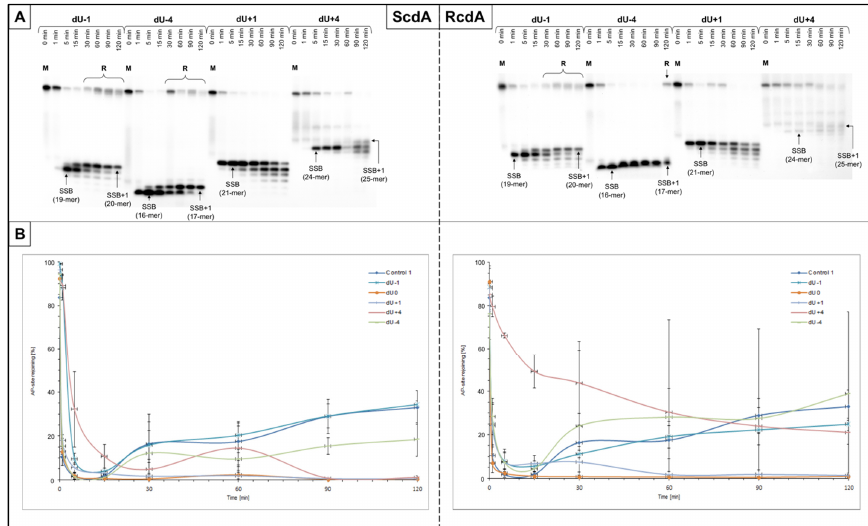
Figure 3. ( A ) The representative autoradiograms presenting the nuclear BER in XPC cell line (the strand incision, elongation, and repair) of dsDNA containing double-stranded clustered DNA lesions (dsCDL) with AP site and ScdA or RcdA on opposite strands distanced by 1–4 base pairs in 3 ′ -end direction (negative numbers) or 5 ′ -end direction (positive numbers); M—length marker (40-mer dsDNA with a single AP site); R—rejoined strand (40-mer dsDNA); SSB—single-strand break (AP site cleavage resulting from the endonucleolytic activity of nuclear extract); SSB+1/SSB+2—cleaved strand with 1 or 2 nucleotide unit incorporated (resulting from polymerase activity of nuclear extract). Each experiment was performed three times for consistency. ( B ) Graphical representation of the AP site rejoining trends (strand reconstitution). Graphs in higher resolution and autoradiograms of all experimental repeats are available in the Supplementary Materials. For the XPC cells, strands containing ScdA were incised with efficiency above 70% after following times: 1 min for ScdA/dU+1; 5 min for ScdA/dU − 1 and ScdA/dU − 4; and 15 min for ScdA/dU+4 (Figure S5B, Table S3). Interestingly, overall incision yields for ScdA were higher than for Control 1 (57.83 ± 7.31% after 5 min, Table S2). For oligos with RcdA, the incision efficiencies were lower than Control 1 (Figure S6, Tables S2 and S4). The fol- lowing AP site incision rates were noted: 50.23 ± 18.55% after 5 min for RcdA/dU+1; 52.18 ± 19.25% after 5 min for RcdA/dU − 4; 48.64 ± 5.15% after 5 min for RcdA/dU − 1; and 23.16 ± 3.63% after 15 min for RcdA/dU+4 (Figure S6B, Table S4). In the case of XPC, the presence of RcdA inhibited the endonucleolytic activity of the NE approximately 20–50% more in comparison to ScdA. The overall incision rates for XPC were increasing in the following order (data compared for 1 min of reaction time): +4 < − 1 < − 4 < +1 (for both isomers). On the other hand, the strands were incised with higher efficiency for BJ than XPC, but with slightly different incision trends. Only for ScdA/dU − 4, SSBs were formed more efficiently than for Control 1 (92.16 ± 7.40% vs. 79.08 ± 5.18% after 1 min, respectively) (Tables S5–S7). The 5 ′ R isomer achieved maximal endonucleolytic activity 4–20% lower than 5 ′ S (except for AP site positioned − 1 to cdA, where it was hydrolyzed 5% better for RcdA than ScdA) (Figures S10B and S11B, Tables S6 and S7). The rate of strand incision for BJ increased in the following order (data compared for 1 min reaction time): for ScdA +4 < − 1 < +1 < − 4; for RcdA +4 < − 1 < − 4 < +1 (Figures S8B–S11B, Tables S5–S7).